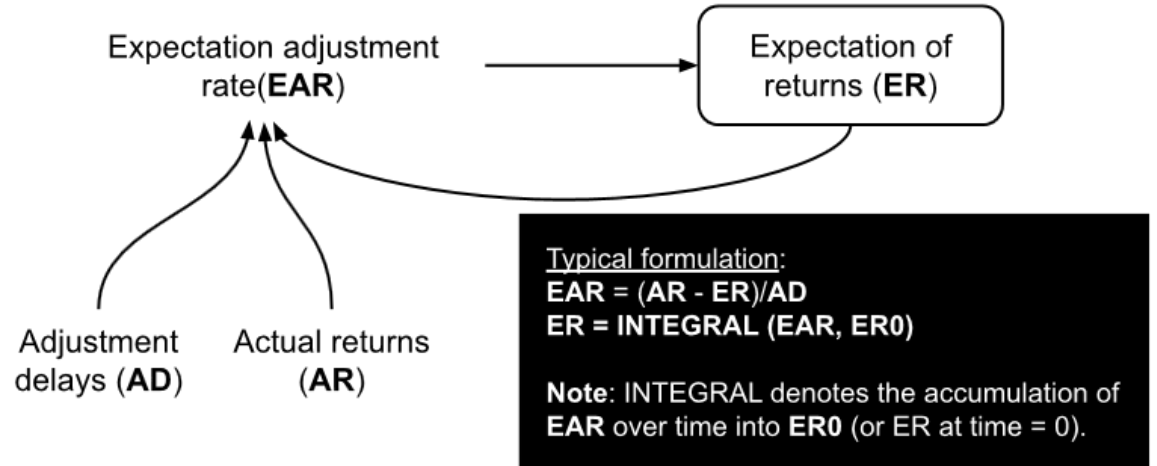
Figure 4. An illustration of how the anchor-and-adjust heuristic works.